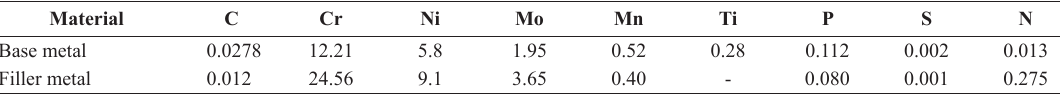
Table 1. Chemical compositions of base and filler metals (wt%). Material